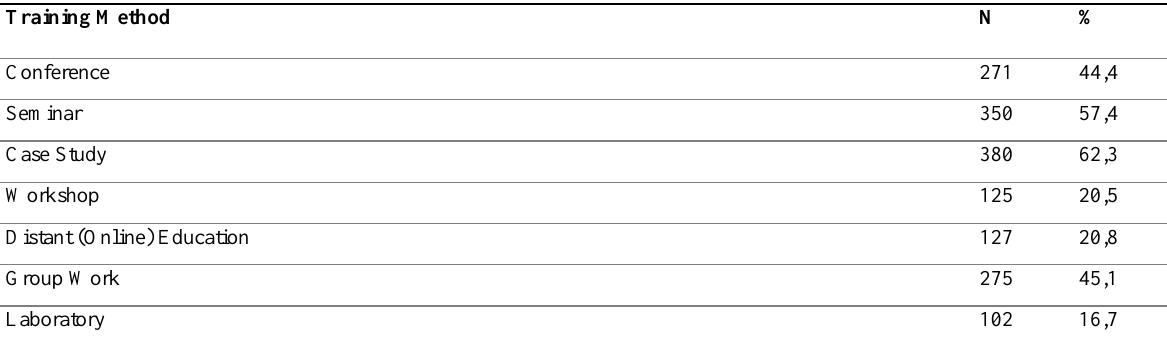
Table 20: In-Service Training Methods